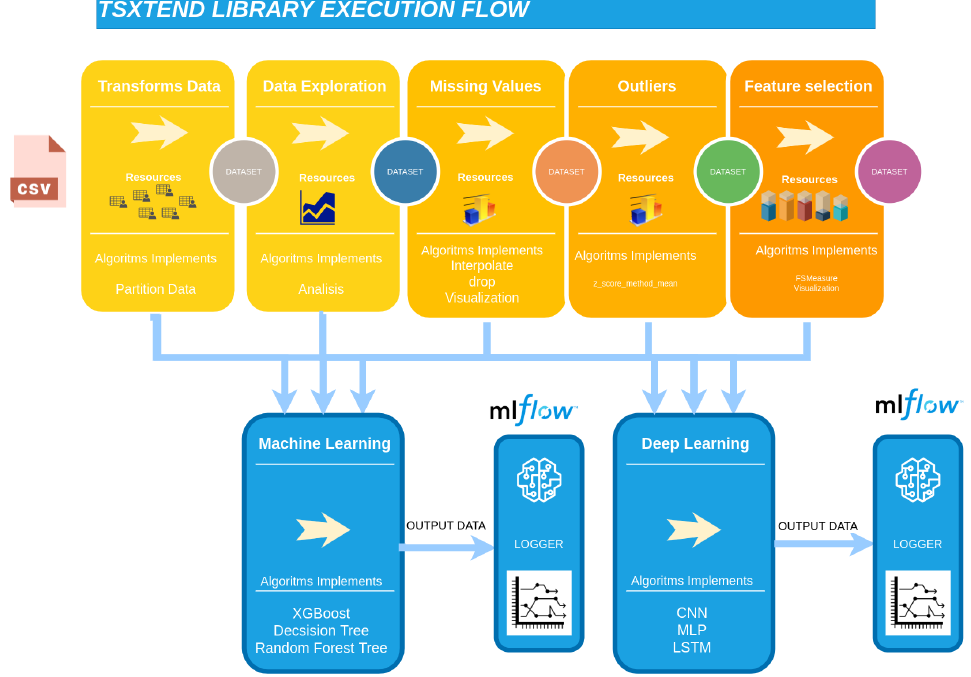
Figure 3. TSxtend execution